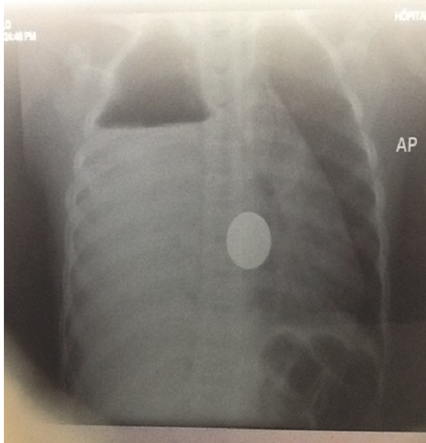
Figure 6: Chest X-ray of the 6Y/O girl after the incident. Massive pleural effusion and air fluid level; foreign body in the right chest at the anatomical site of the esophagus and radiological signs of perforation.